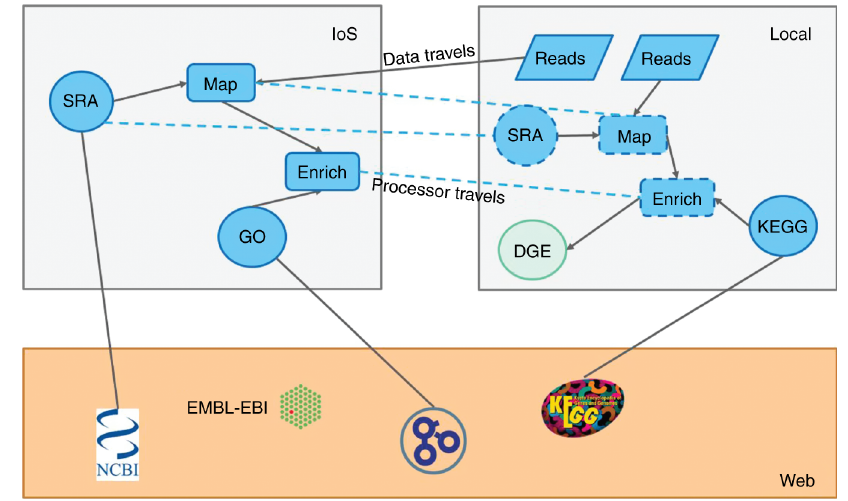
Figure 3: The development of data analysis workflows using a mixture of public and private data and tools. The orange box contains some public data sources (e.g.; GO [24] and KEGG [25]). Some have production level connector nodes (blue circles, IoS box) while others have private connectors (local). Processing nodes (rounded rectangles) are used to transform data. As in most WMS, Data can travel but in this system processing nodes can travel as well (dashed blue lines). Local data (blue parallelogram, e.g.; proprietary) can be processed locally so that it does not need to be uploaded. Result visualization is just another data transformation (green